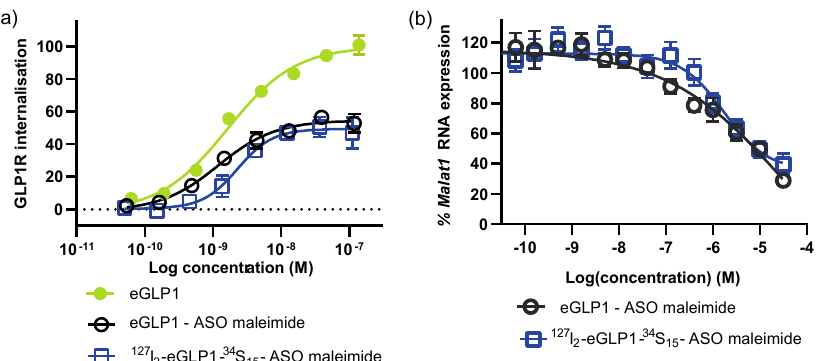
Figure 3. Verification of 127 I 2 -eGLP1- 34 S 15 -ASO function. ( a ) GLP1R internalization assessed in U2OS cells using the PathHunter assay. ( b ) Malat1 RNA expression in GLP1R-HEK293 cells after incubation with unlabeled or labeled eGLP1-ASO. Data shown as mean ± SEM for 3 independent experiments performed in duplicate.